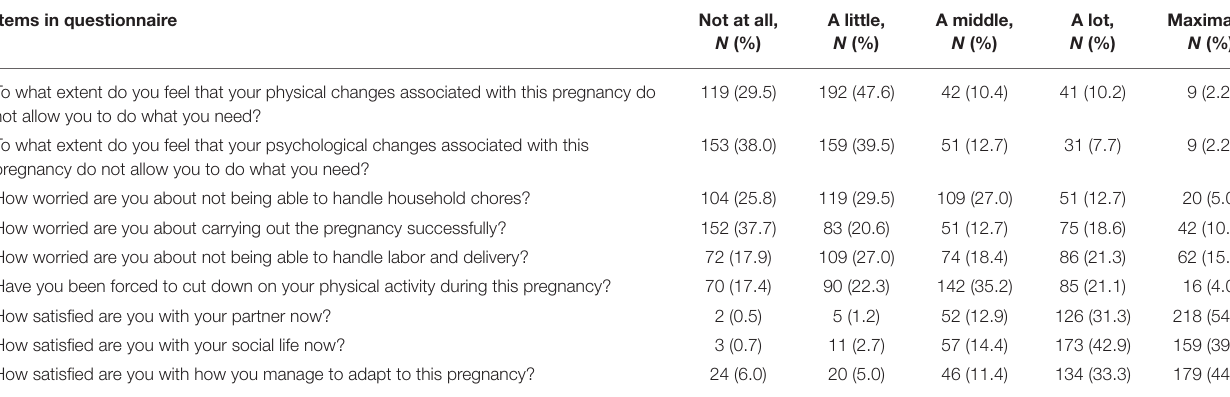
TABLE 2 | Quality of Life of the study respondents. Items in